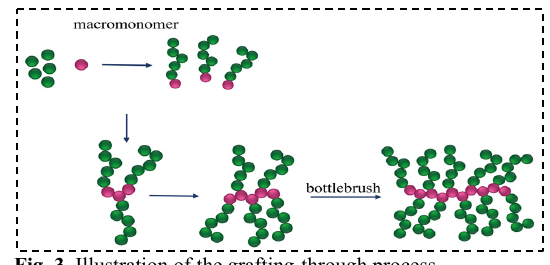
Fig. 3. Illustration of the grafting-through process.